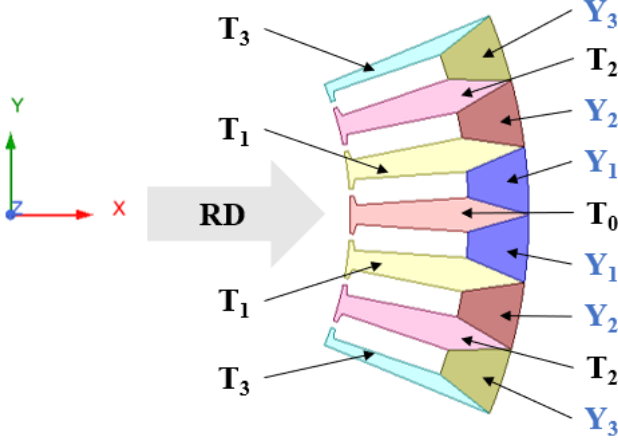
Figure 3. Schematic diagram of segmented modeling of grain-oriented silicon steel stator core.